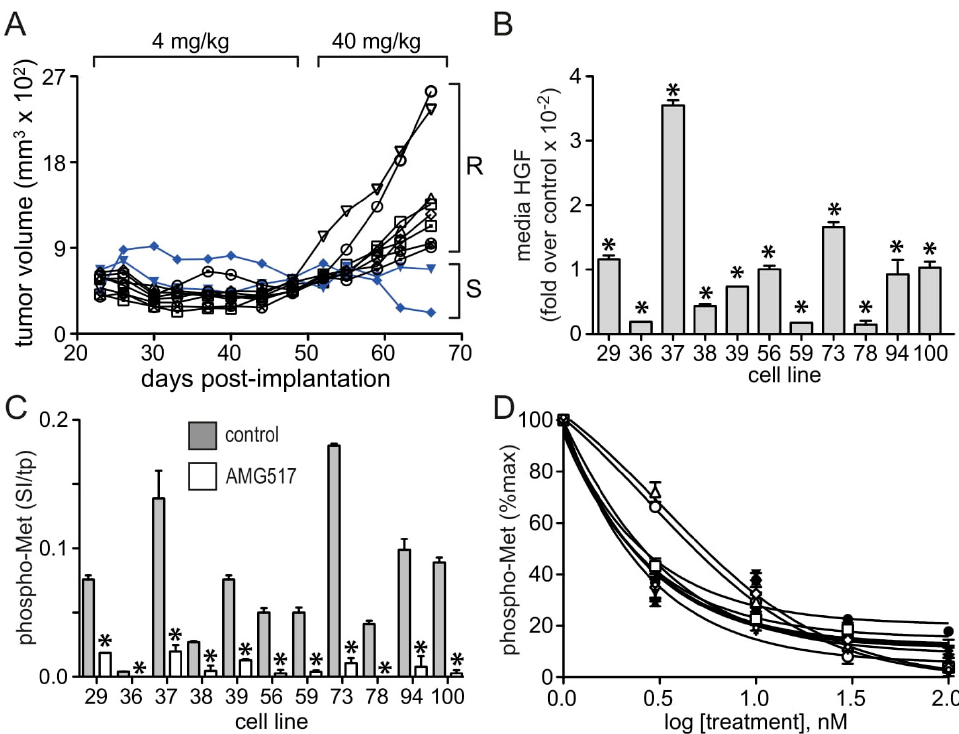
Figure 4. Acquired resistance to rilotumumab by U87 MG xenografts in vivo. ( A ) U87 MG tumor xenografts grown in mice (n = 10) treated with rilotumumab at 4 mg/kg until day 48 post-implantation and thereafter with 40 mg/kg displayed drug sensitivity (“S”) or acquired drug resistance (“R”) by day 68. ( B ) Mean HGF content (corrected for total cell protein; ±SD, n = 3), expressed as fold over the parental U87 MG cell line (control), in 24 h media conditioned by 11 cultured cell lines derived from rilotumumab-resistant U87 MG tumor xenografts that were generated as described in panel a. ( C ) Phospho-Met content (mean signal intensity/mg total protein ± SD, n = 3) in 11 cultured cell lines derived from rilotumumab-resistant U87 MG tumor xenografts in the absence (gray bars) or presence (white bars) of 100 nM AMG517. ( D ) Dose-dependent inhibition of phospho-Met (mean % maximum ± SD, n = 3) in 11 cultured cell lines derived from rilotumumab-resistant U87 MG tumor xenografts by the selective small-molecule Met kinase inhibitor AMG517. Asterisks indicate a significant difference from control ( p < 0.05).